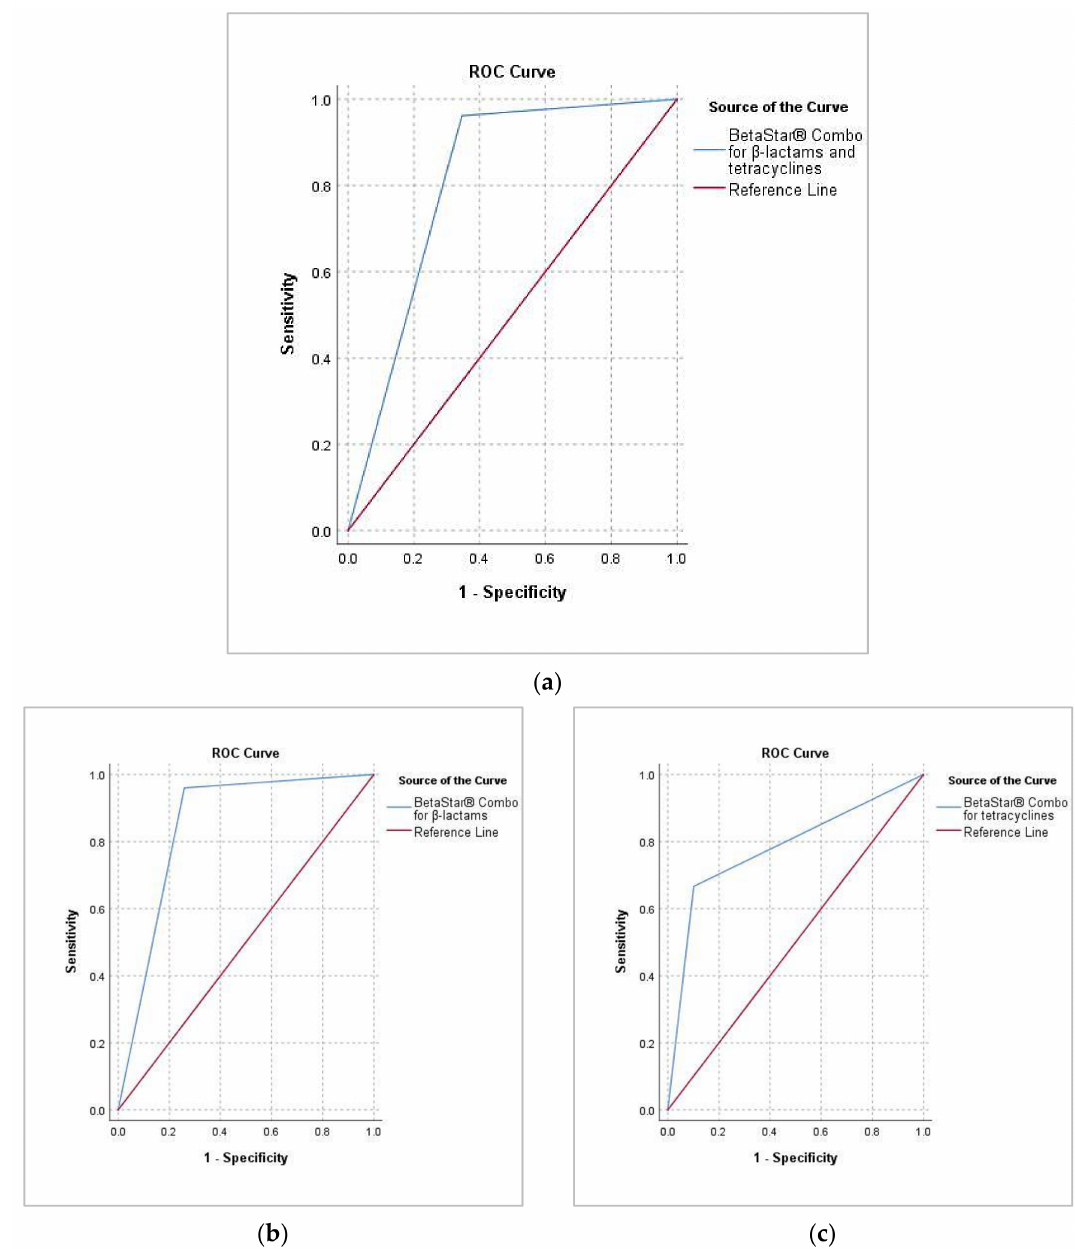
Figure 4. Receiver operating characteristic curve (ROC) curve obtained for the accuracy of BetaStar ® combo compared to LC-MS/MS for both antibiotic families ( a ) and separately, for β -lactams ( b ) and tetracyclines ( c